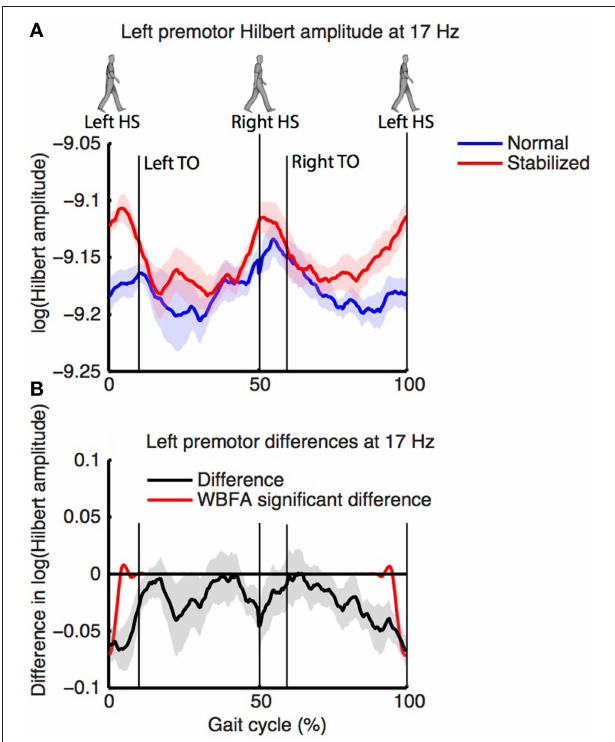
FIGURE 9 | (A) Normalized power over the gait cycle (estimated via Hilbert transform) of left premotor area (at 17Hz) during normal (blue) and stabilized (red) walking. Panel (B) displays the difference between conditions, with values below zero representing higher power in the stabilized condition. Shaded areas represent standard